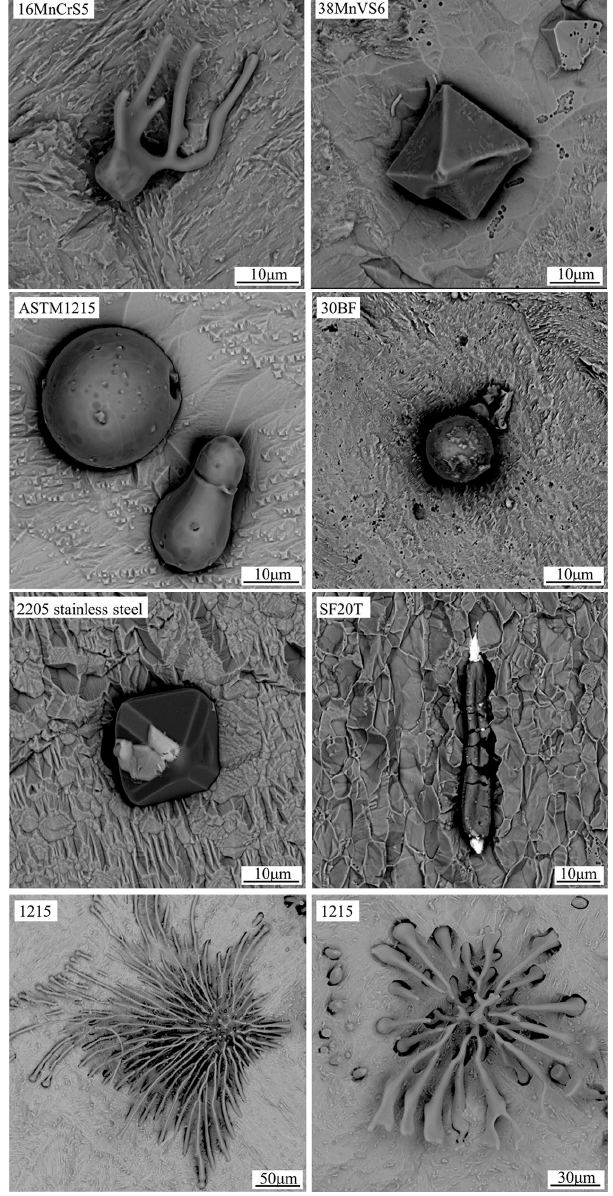
Figure 10. Morphologies of sulphides in different steel grades, as seen in Zhang et al. [97]. Copyright 2019, Springer Nature. Ti based inclusions and particles were extracted from Ni-based steel alloy 825 (0.76 to 0.8 wt.% C, 38 wt.% Ni, 20 wt.% Cr) for 3D characterization, especially TiN particles